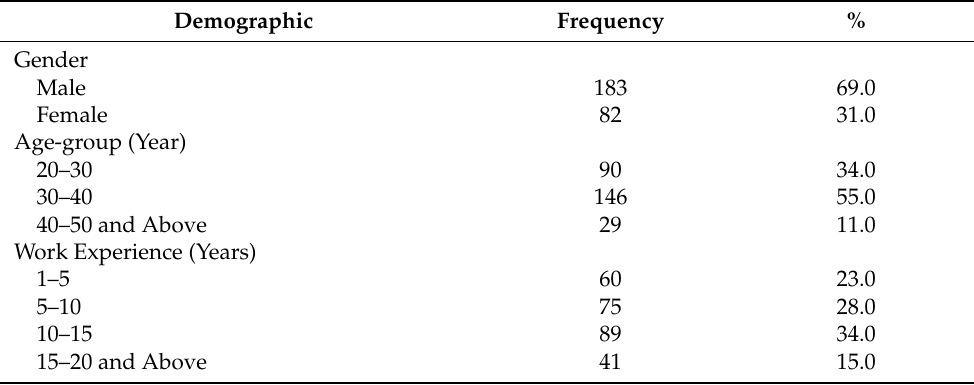
Figure 1. The proposed research model, hypothesized by authors. This model comprises four constructs: substantive staging of sustainable servicescape (SSOS) = the independent variable (X1), communicative staging of sustainable servicescape (CSOS) = independent variable (X2), overall perceived image (OPI) = mediating variable (M), and behavioral intentions (BI) = the dependent variable (Y). Table 1. Demographic